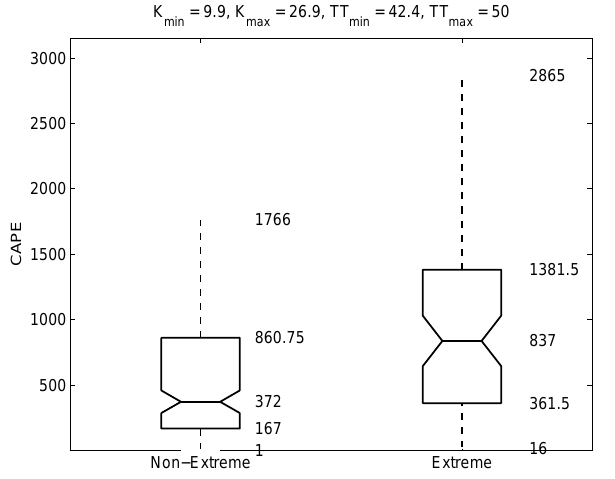
Fig. 1. The distribution of the values of the K and TT indices of all Fig. 2. The distribution of the values of the CAPE index for the cases with non-zero value of CAPE. days where extreme (right) and non-extreme (left) events occurred. Fig. 3. The distribution of the values of the CIN index for the days Fig. 2. The distribution of the values of the CAPE index for the days where extreme (right) and non-extreme (left) events occurred.